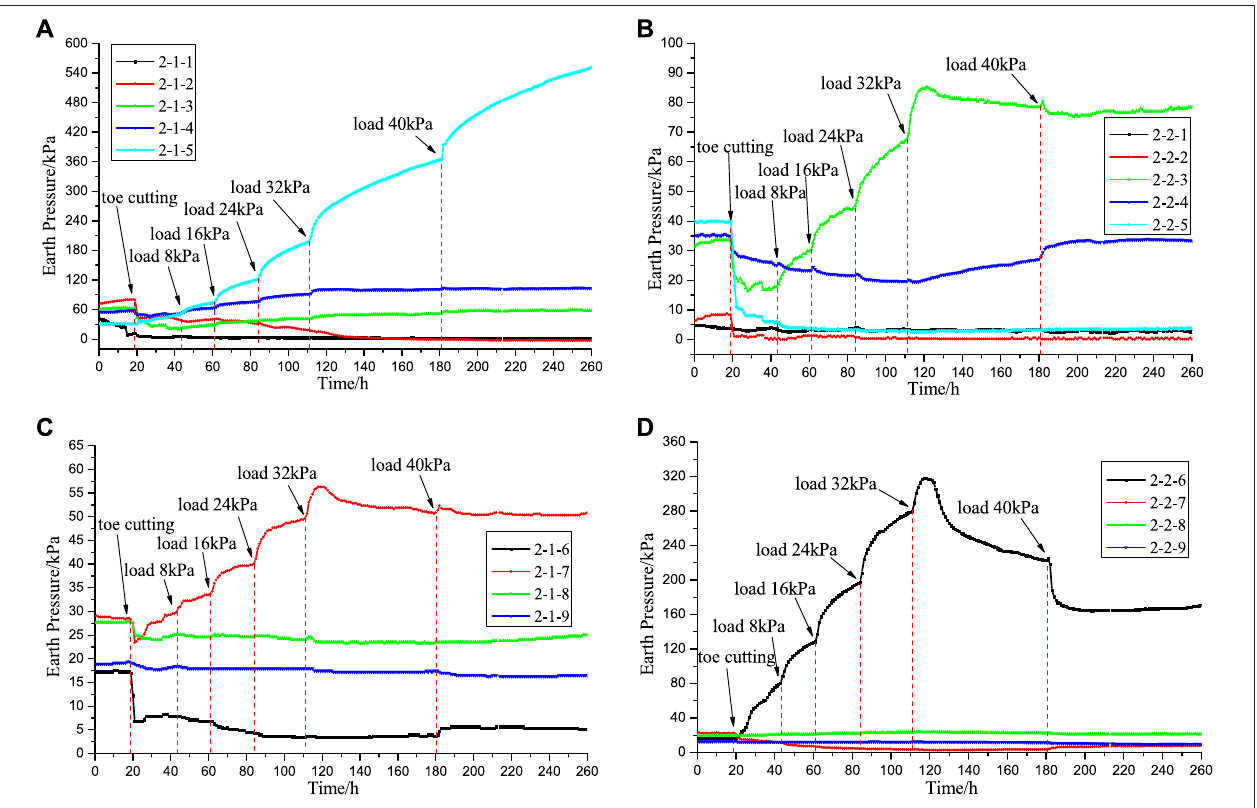
FIGURE 9 | Earth pressure measured in front of and behind pile S5: (A) earth pressure in front of the anti-sliding segment of pile S5, (B) earth pressure behind the anti-sliding segment of pile S5, (C) earth pressure in front of the anchoring segment of pile S5, and (D) earth pressure behind the anchoring segment of pile S5.